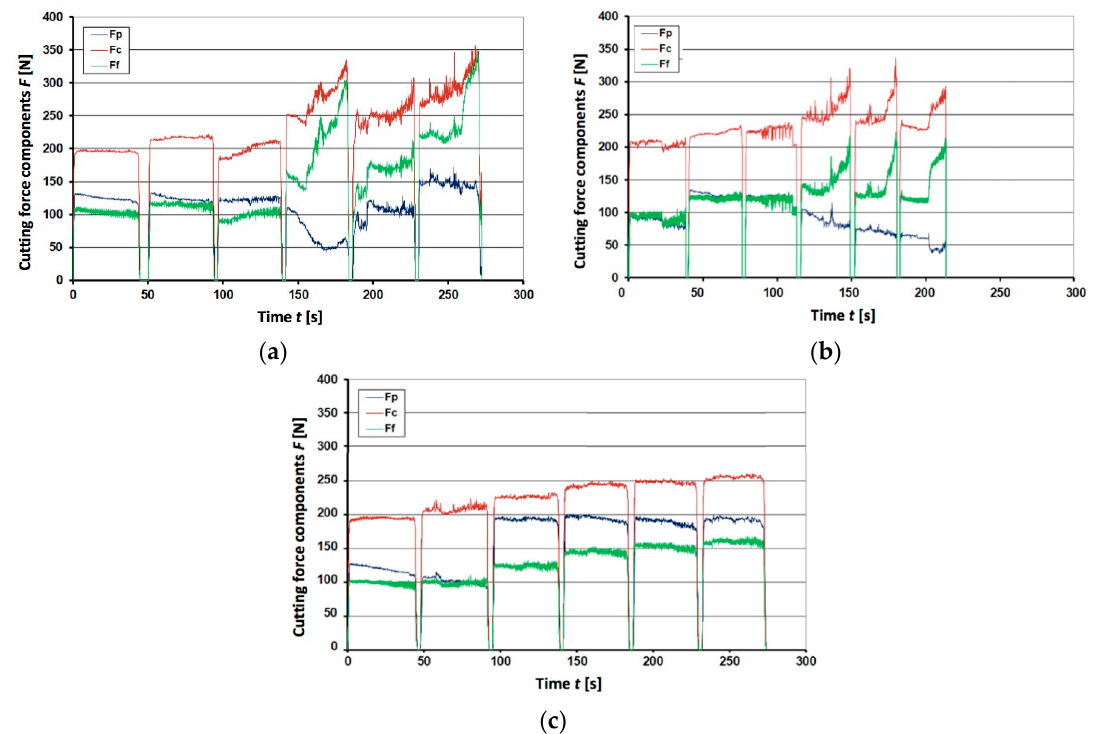
Figure 5. Registered force components F p , F c , and F f for the insert IS9 without implanted ions: ( a ) 1st edge; ( b ) 2nd edge; ( c ) 3rd edge.